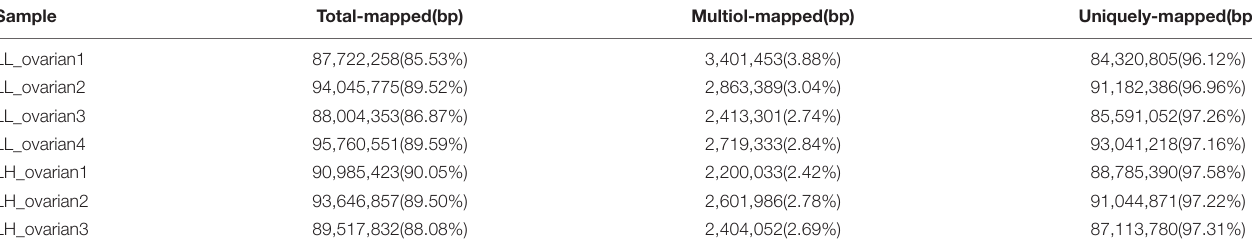
TABLE 2 | Statistics of the mapping result.